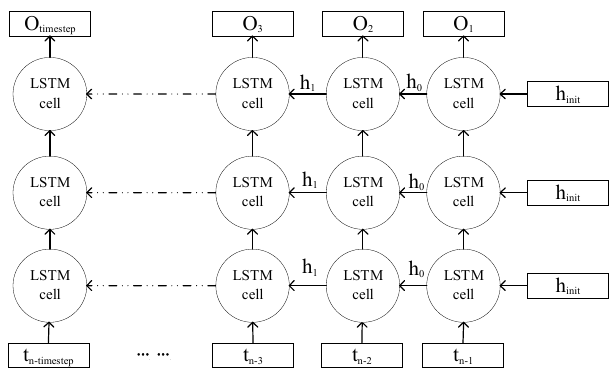
Figure 3. The structure of the multi-layer LSTM neural network.